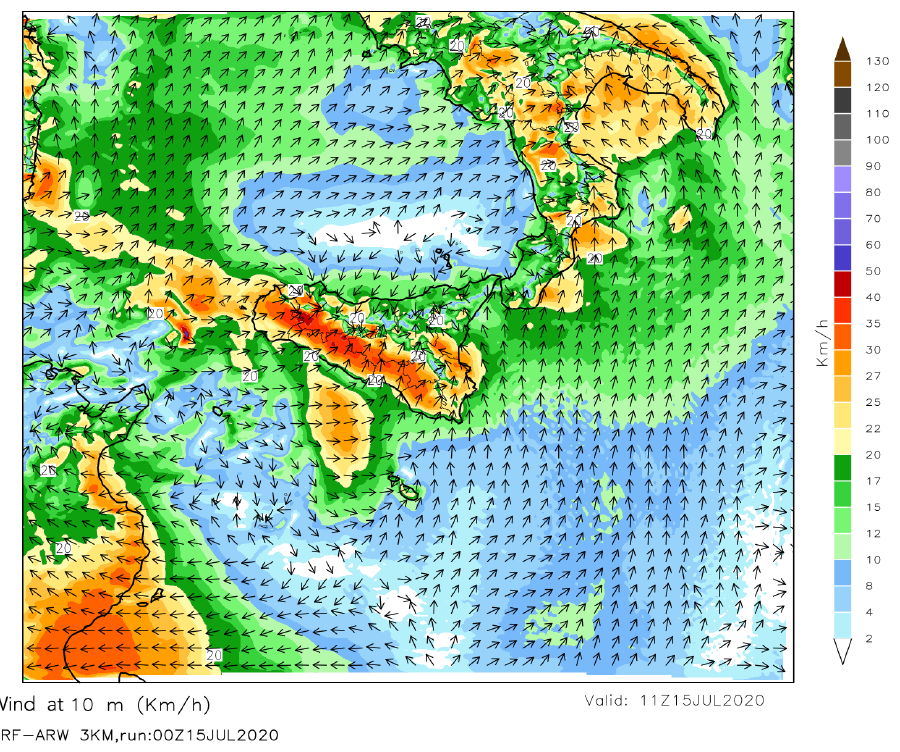
Figure 15. Wind map at 10 m obtained by using the WRF model at 3 km. The black arrows indicate the direction of the wind; the color bar indicates the speed. Furthermore, from this figure it is possible to see the confluence area close to